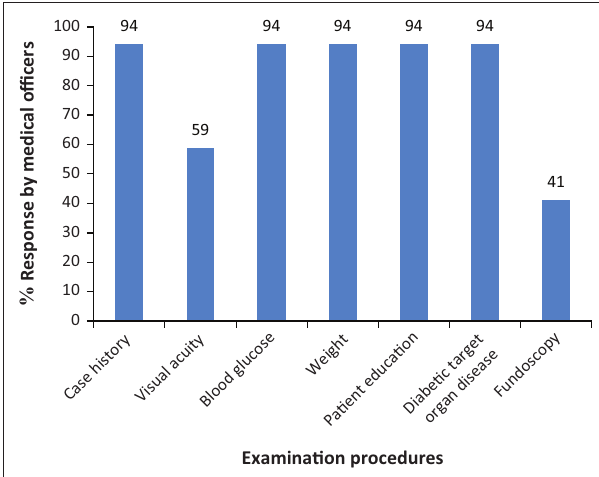
TABLE 2: Age, year of qualification and duration of practice of optometrists and ophthalmic nurses. Participant profile